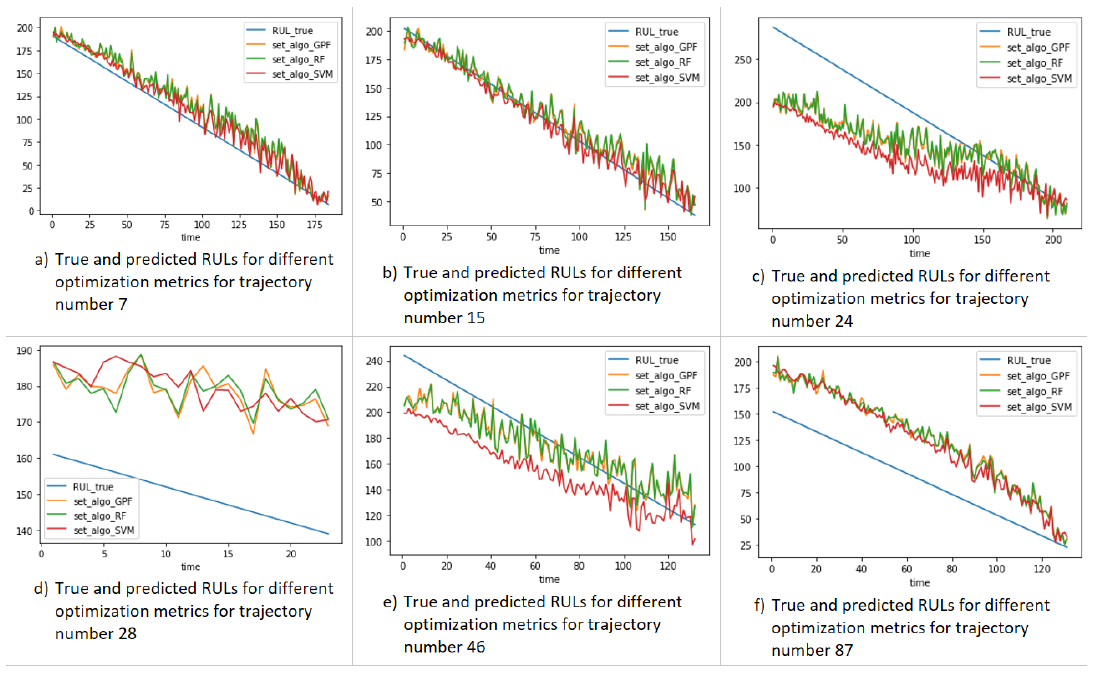
Figure 11. True and predicted value on dataset FD002 for six different trajectories when using the GPF, RF, and SVM.